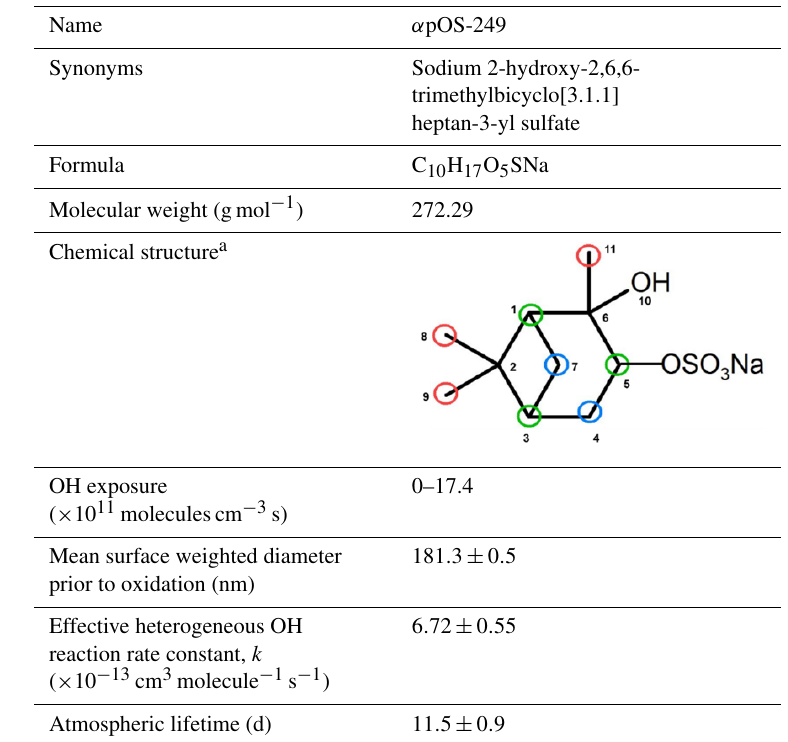
Table 1. Information of the α -pinene-derived organosulfate investigated in this